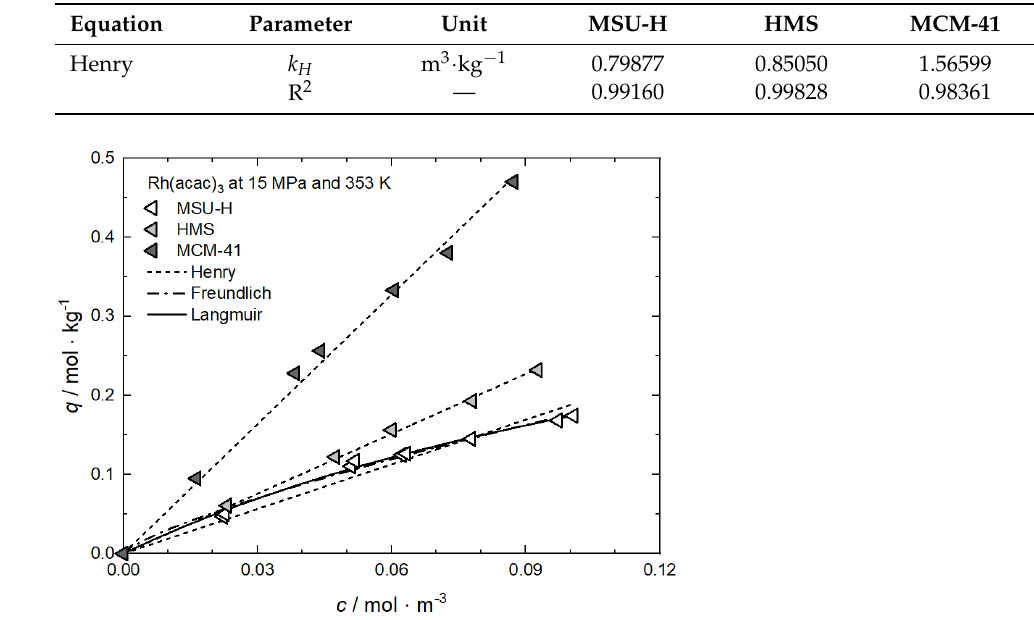
Table A11. Adsorption isotherm parameters for Rh(acac) 3 from scCO 2 solution at 15 MPa and 333 K on different substrates [62].